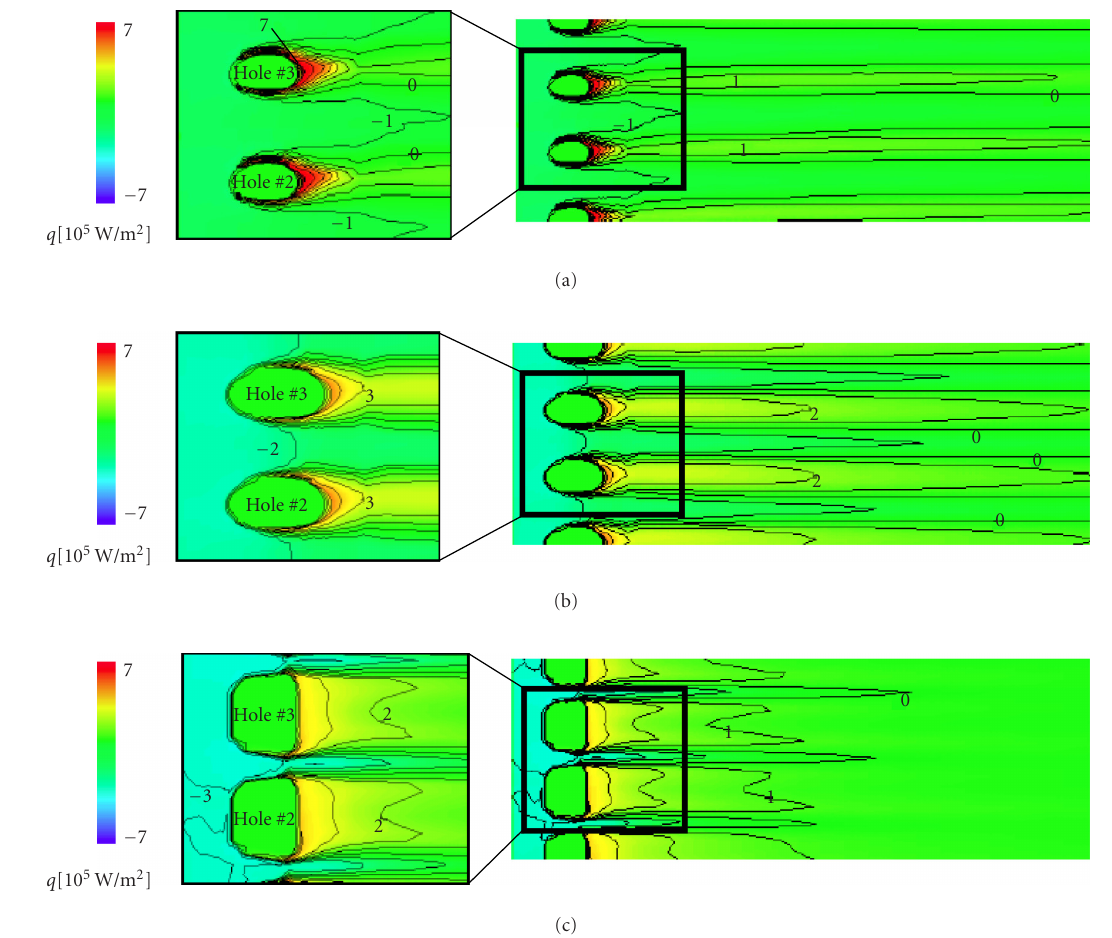
Figure 6: Distribution of the specific heat flux rate for the conjugate surface ( M = 1 . 0): (a) cylindrical hole, (b) di ff user hole, and (c) fanshaped